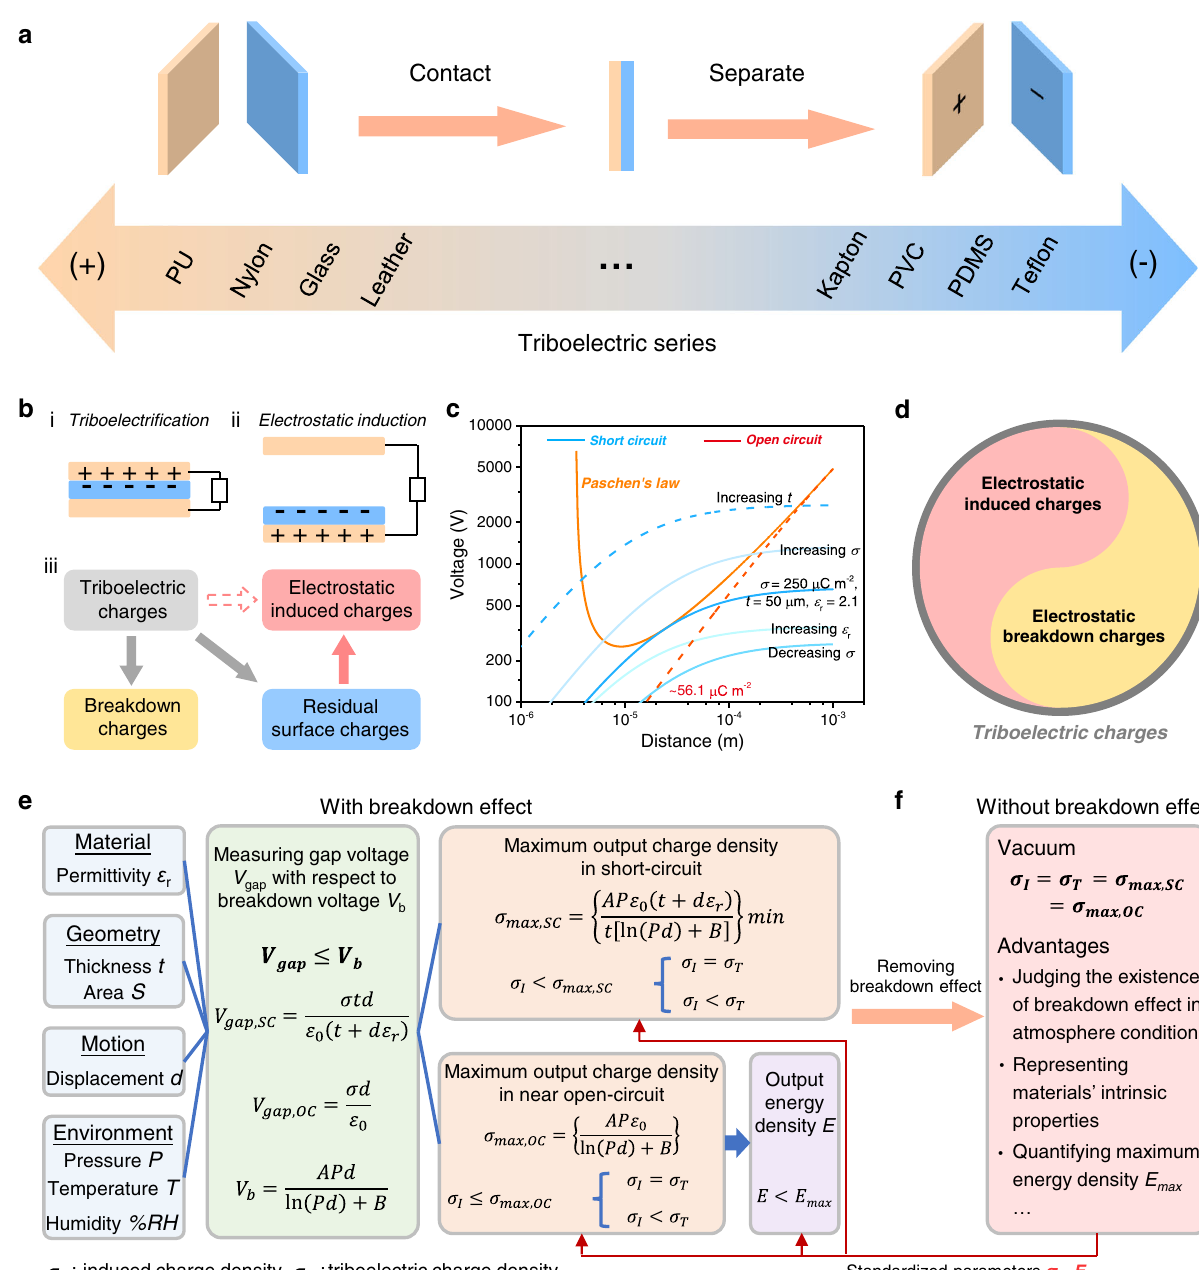
Fig. 1 | Strategies for assessing triboelectric performance of dielectric materi- als.a Representedqualitativetriboelectricseries.PU,polyurethane;PVC,polyvinyl chloride; PDMS, polydimethylsiloxane. b Schematic diagram shows working mechanism andchargetransferring process of TENG. c Relationshipof breakdown voltageandgapvoltageacrossthetriboelectriclayersatvariousdistancesinTENG. d Schematic diagram shows the relationship between triboelectric charges and